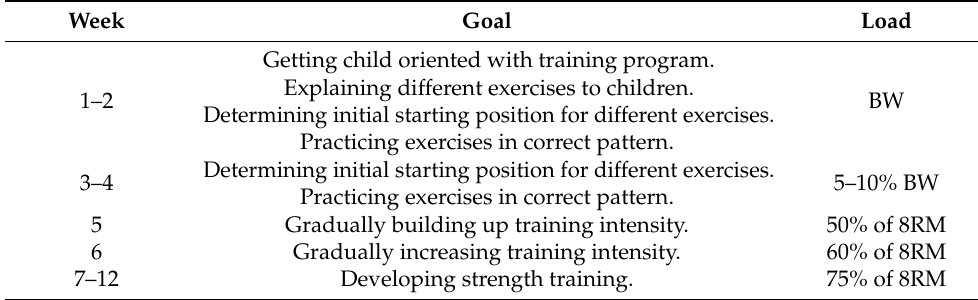
Table 1. Weekly training and timing of the 8 RM.